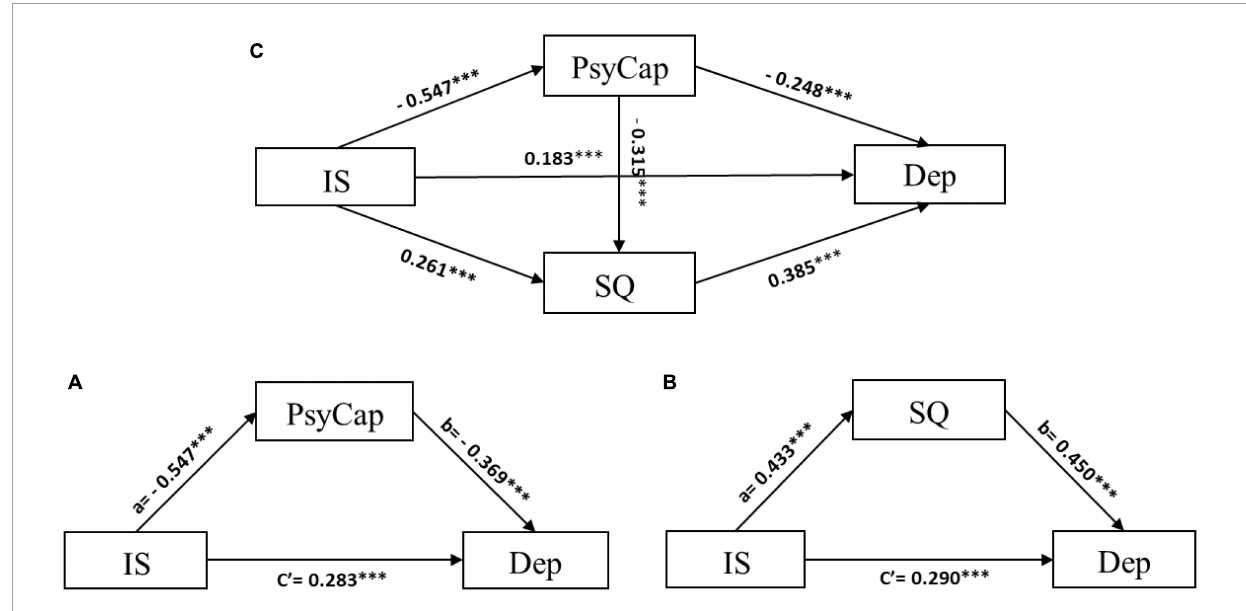
FIGURE2 The characteristics of models. In this figure, psychological capital (PsyCap) as an independent mediator of the model (A) ; sleep quality (SQ) as an independent mediator of the model (B) ; psychological capital (PsyCap) and sleep quality (SQ) jointly play a mediating role of the chain mediation model (C) . ∗∗∗ p <